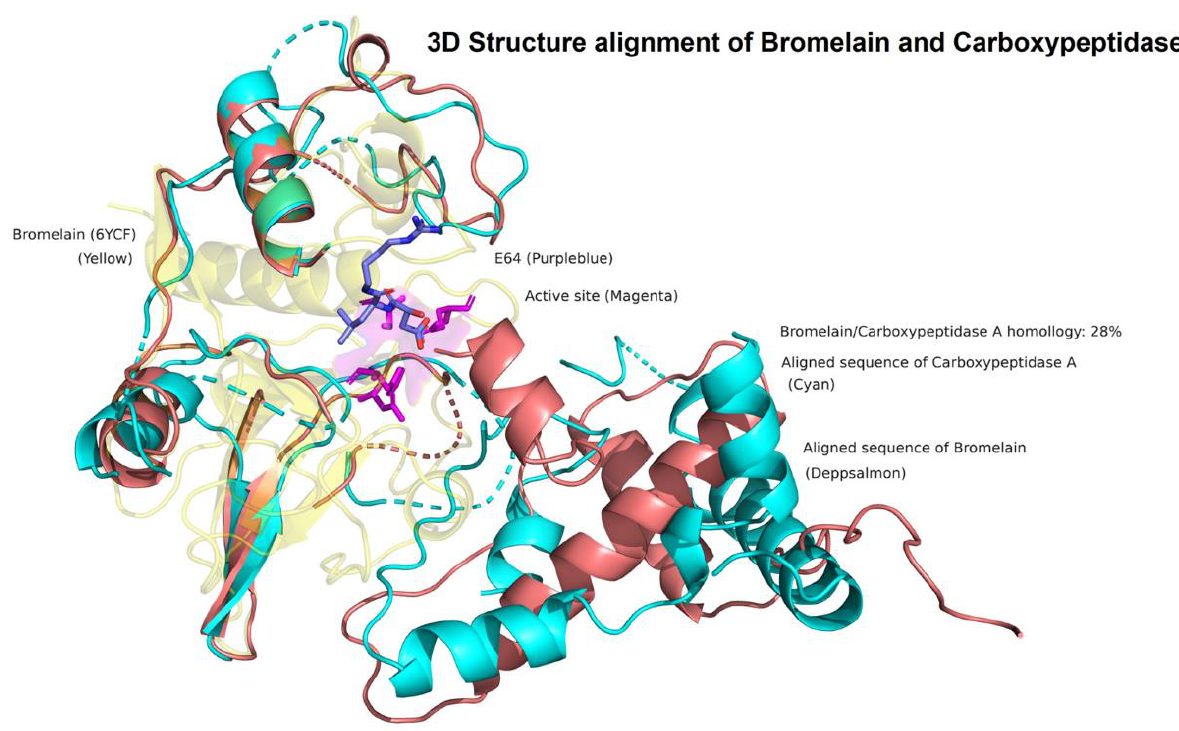
Figure 2. 3D Structure alignment of Bromelain and Carboxipeptidase A. The exploratory analysis showed that Bromelain and Carboxypeptidase A mostly share a similar structural conformation surrounding the binding pocket, despite its 28% sequence homology and different catalytic mechanisms.